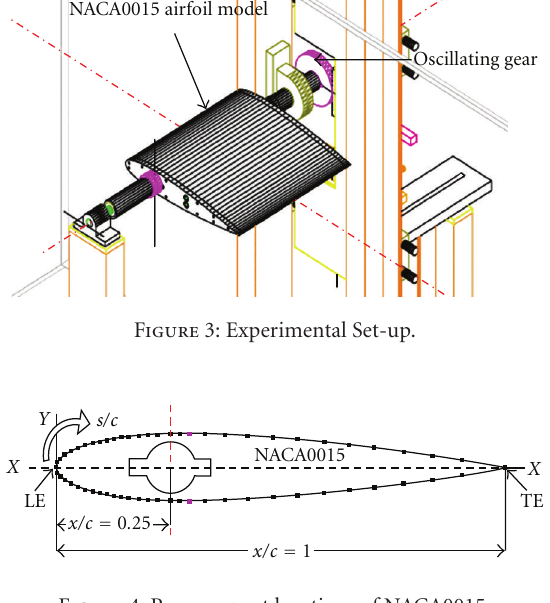
Figure 4: Pressure port locations of